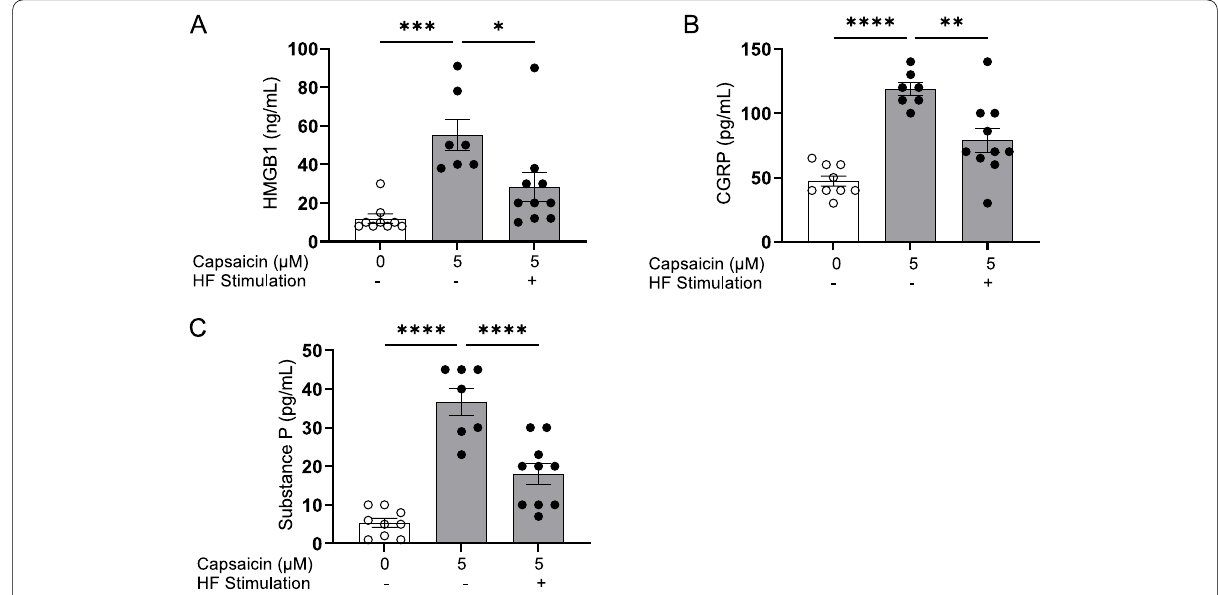
Fig. 2 HFES attenuates capsaicin‑ induced HMGB1, CGRP and substance P release. DRGs from C57BL/6 mice were harvested and plated on MEA plates for 48–72 h. Cells were simultaneously stimulated with capsaicin (5 μM) and high frequency electrical stimulation for 15 min. Sixty minutes post‑stimulation, cell supernatants were harvested and A HMGB1, B CGRP and C substance P measured. Data is represented as individual experimental data points with mean SEM. N 6‑8 per group. One‑way ANOVA followed by Tukey’s multiple comparisons test between groups. ± = * P < 0.05, ** p < 0.01, *** p < 0.001, **** p <